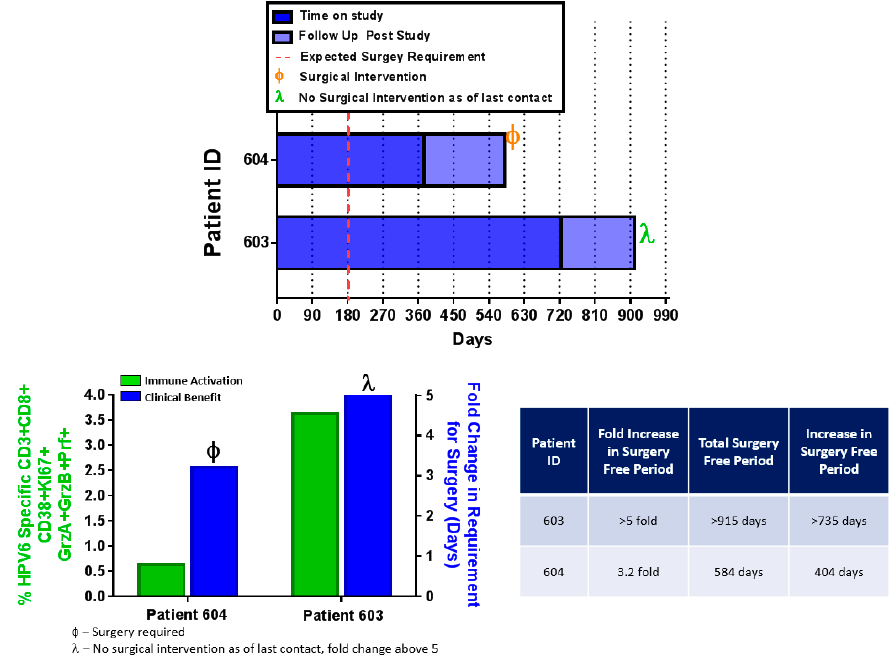
Figure 5. Treatment of RRP patients with INO-3106 imparts clinical benefit in the form of avoidance of surgery. Top panel: Swimmers plot indicating the length of time in Days that patients 604 and 603 were surgery-free. The dotted red line indicates the timepoint surgery would be expected based on previous surgery frequencies prior to intervention with INO-3106, indicates the timepoint at which patient 604 required surgery, and indicates that as of the indicated timepoint, patient 603 remains surgery free. Bottom left panel: Green bars track to the left y-axis and indicate the magnitude of HPV6-specific CD8+ T cells expressing CD38, Ki67, Granzyme A, Granzyme B and Perforin. Blue bars track to the right y-axis and indicate the fold-change in surgery-free time relative to the expected surgery frequencies for these patients. Bottom right – the chart indicates patient ID, fold increase in surgery free time, total surgery free time, and the increase in surgery free time experienced by these patients after treatment with INO-3106.